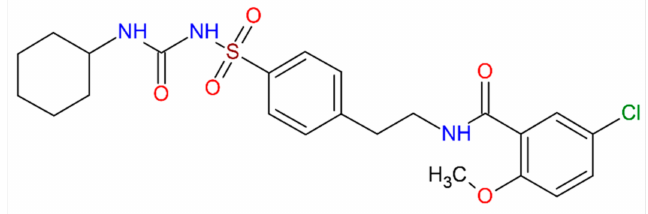
Figure 1. Molecular structure of the model drug, glibenclamide